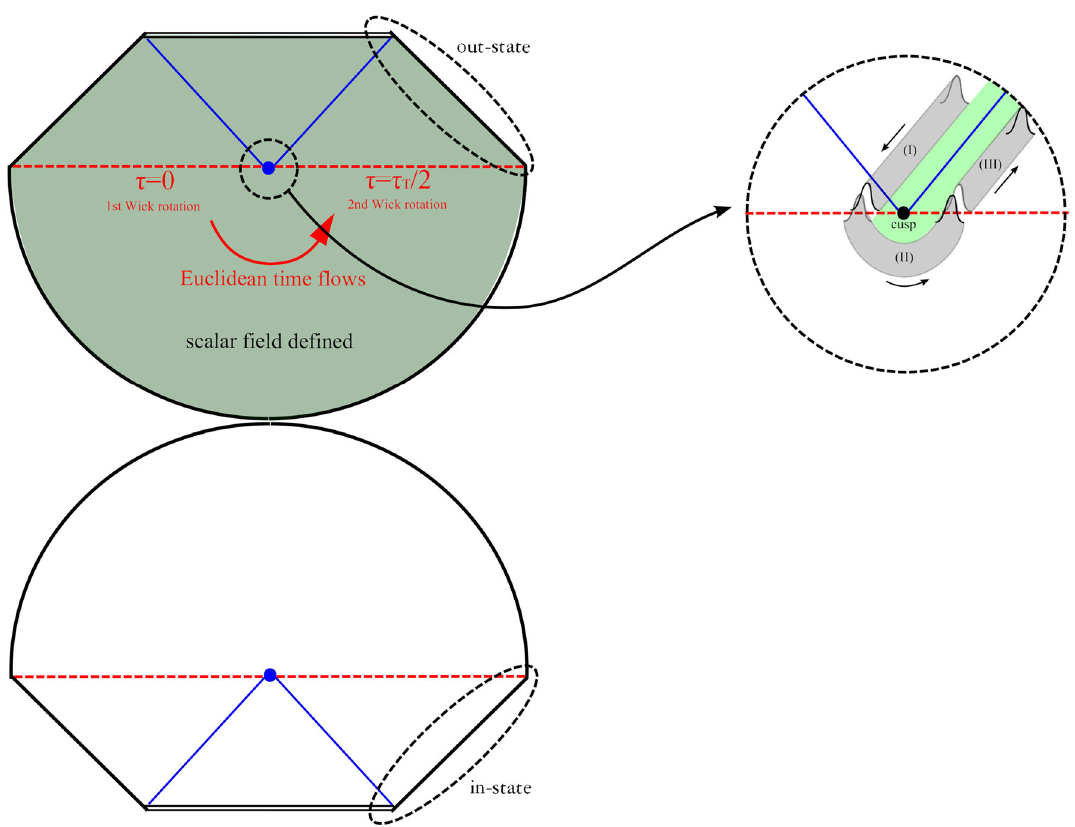
As we impose the reality condition at (III), the solution is complex- valued for (I) and (II). Since the out-going pulse has energy δ M , the green colored region should have mass M (cid:6) = M − δ M . To cancel out the boundary term at infinity, we define the Euclidean time period as τ = 8 π M . Therefore, the horizon becomes a cusp T